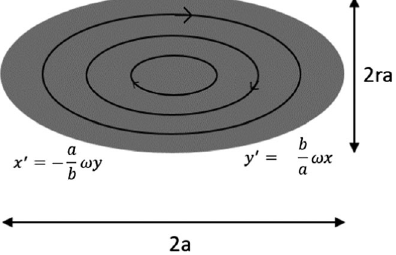
FIG. 9. Ellipse performing intrinsic and concentric rotation.